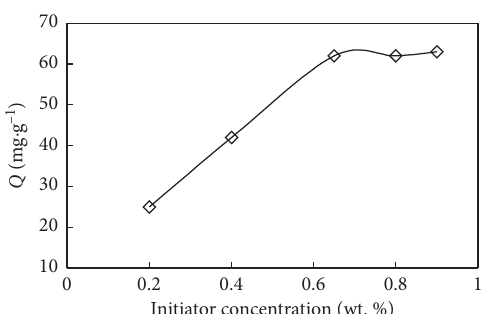
Figure 2: Effects of the initiator on Cu 2+ absorption capability.